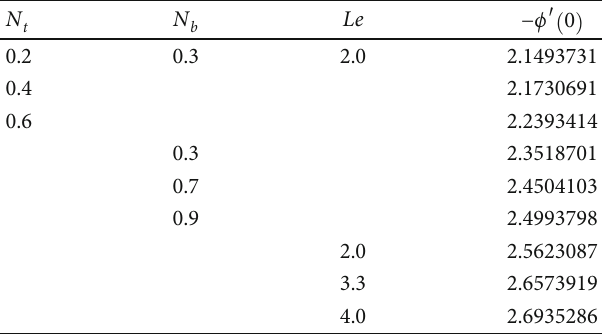
Þ f ″ ð 0 Þ = ð μ / μ f hnf f